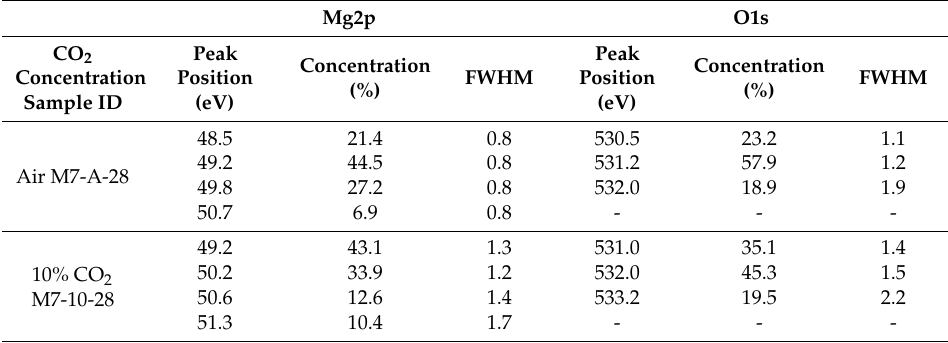
Figure 7. Mg2p BE for samples exposed to air and CO 2 for seven days.